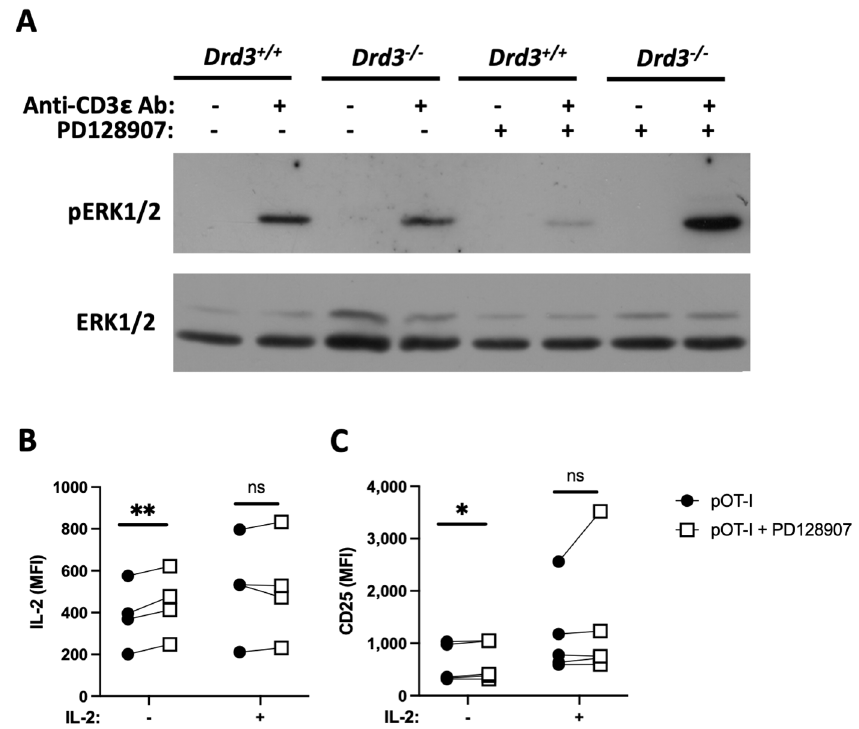
Figure 4. DRD3 stimulation reduces ERK1/2 phosphorylation and increases IL-2 production trig- gered by the TCR activation. ( A ) Splenic Drd3 +/+ or Drd3 − / − CD8 + T-cells were purified and then left unstimulated or stimulated with either anti-CD3 Ab, PD128907, or both together for 5 min. Afterwards, cells were lysed and the extent of ERK1/2-phosphorylation (pERK1/2; top panel) or total ERK1/2 (ERK1/2; bottom panel) were analysed by western blot. Results from a representative of three independent experiments are shown. (B-C) Drd3 +/+ OT-I CD8 + T-cells were left untreated or treated with 50 nM PD128907 for 30 min and then activated in the presence or absence of exogenous IL-2 (as described in Section 2.3.). The intracellular IL-2 production ( B ) and surface CD25 expression ( C ) were assessed by flow cytometry. Values are the MFI obtained in four independent experiments. Each symbol represents data obtained from a different mouse. Data from four independent experiments are shown. *, p < 0.05; **, p < 0.01; by paired Student’s t -test.